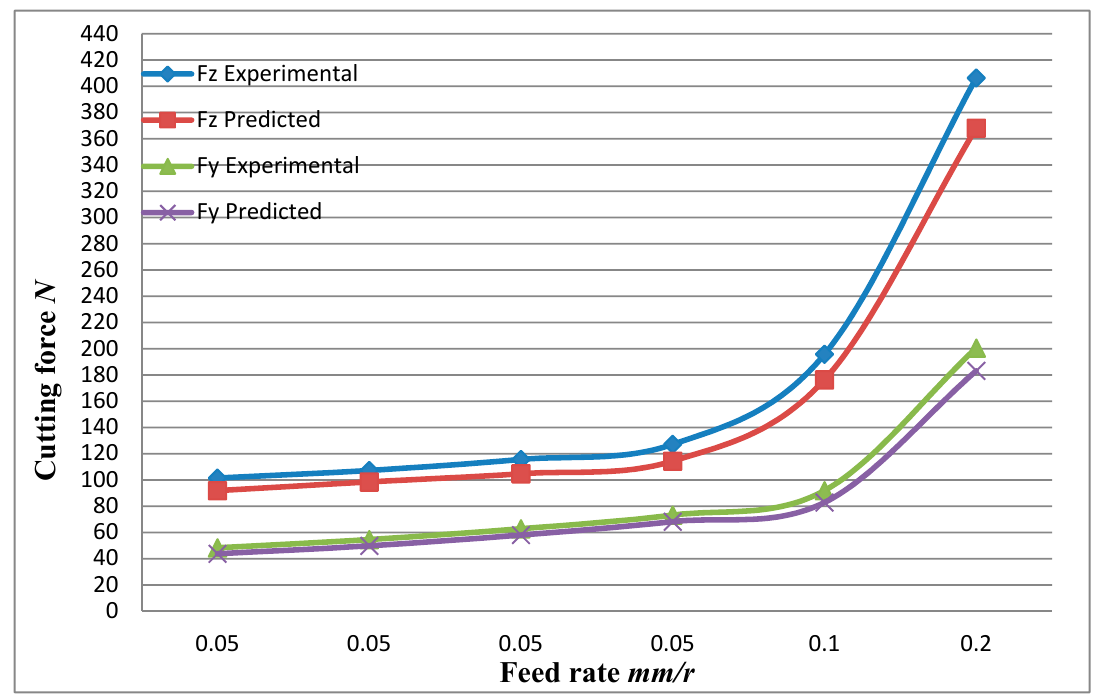
Figure 33. comparisons of simulated cutting force and experimental values. Figure 33. Comparisons of simulated cutting force and experimental